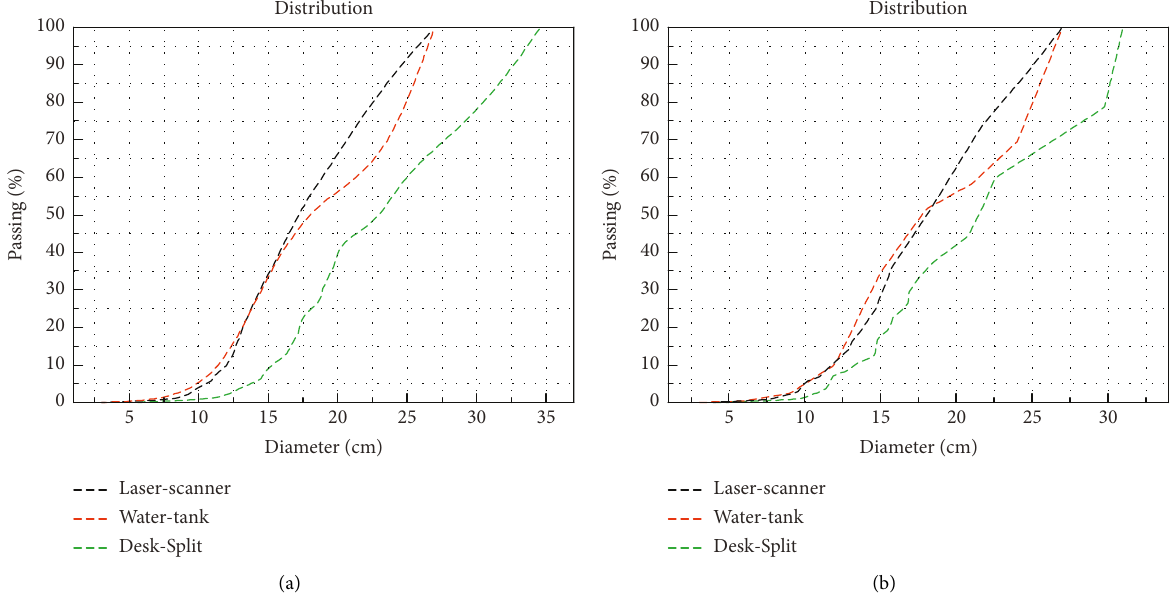
Figure 12: Size distribution of the stacked blocks using interval of the surface blocks and diameter compensation. (a) Case 1. (b) Case